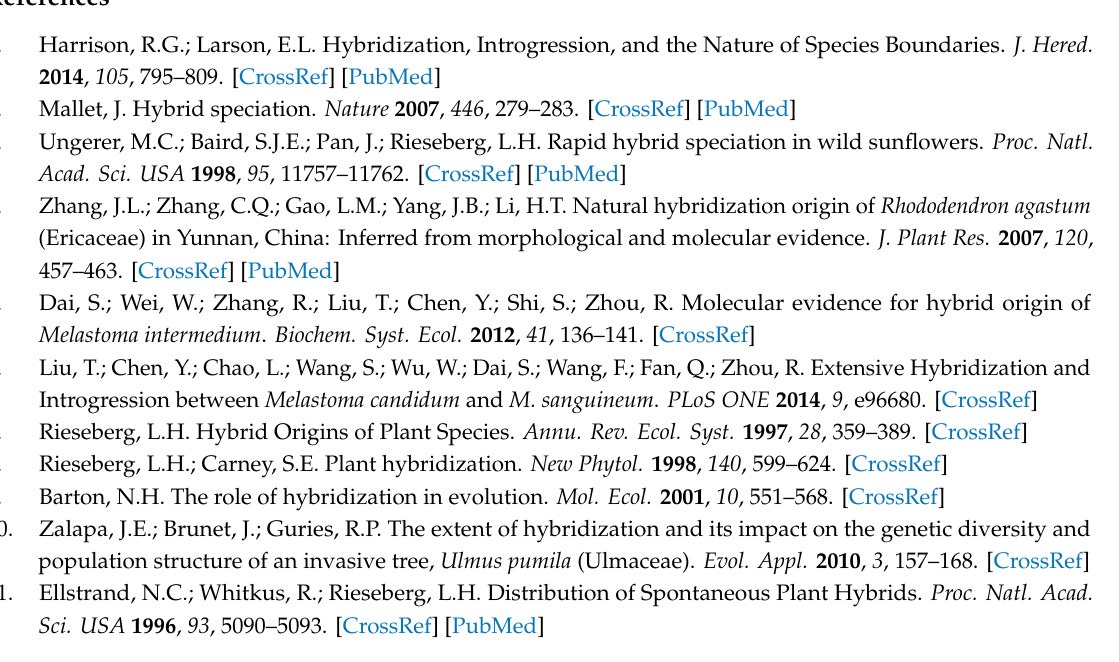
Table S1. Alleles at 29 loci used for STRUCTURE and NewHybrids